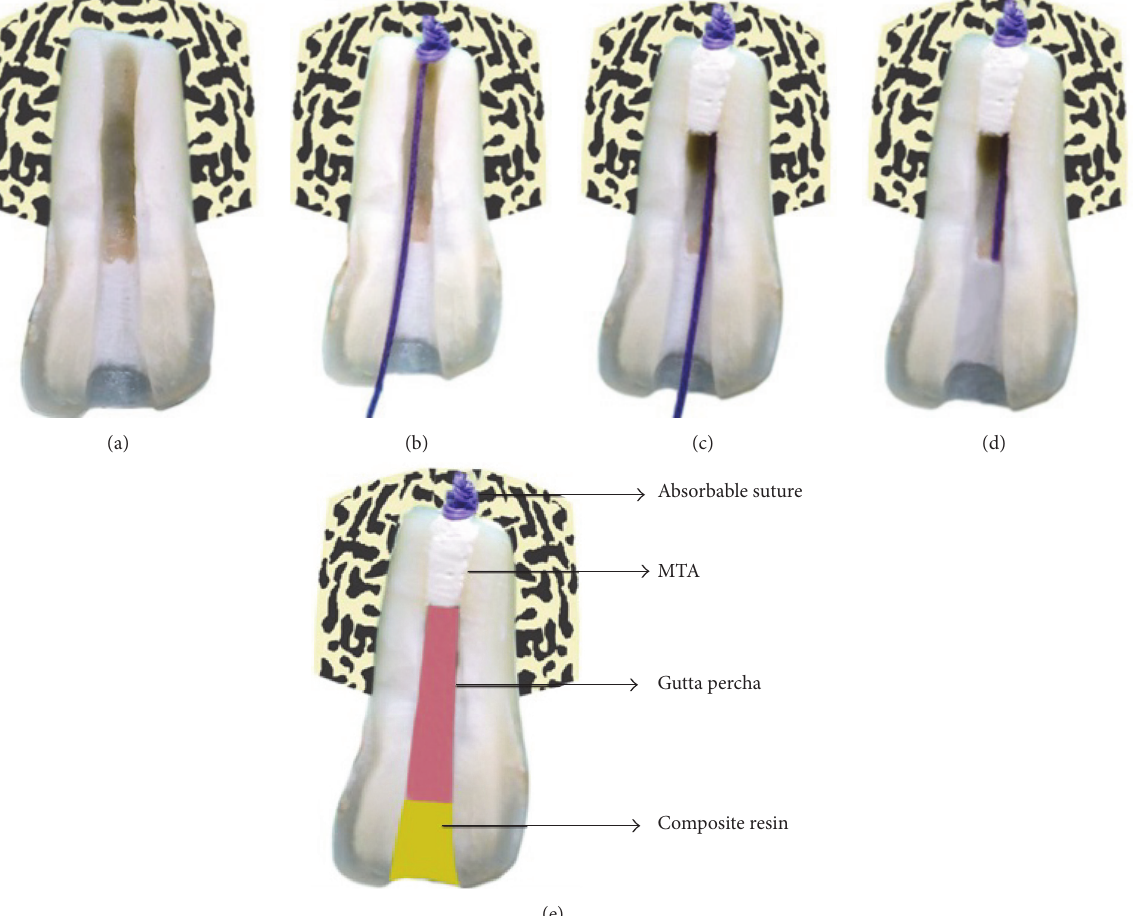
Figure 3: Modified suture apical matrix concept. (a) Tooth with immature apex. (b) Suture matrix placed at the apex. (c) MTA is condensed against the matrix. (d) The free end of the suture is cut. (e) Obturation is done followed by a permanent coronal restoration.